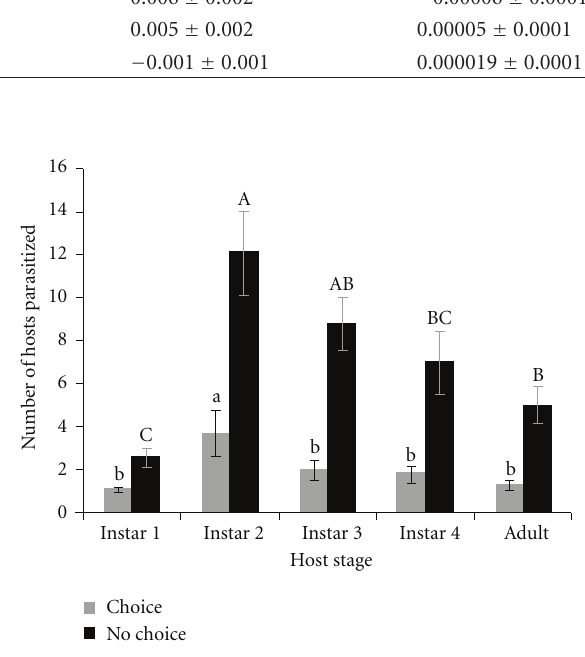
Figure 1: Host-stage preference of Sitobion avenae parasitized by Praon volucre in choice ( (cid:2) ) and no-choice ( (cid:3) ) tests.